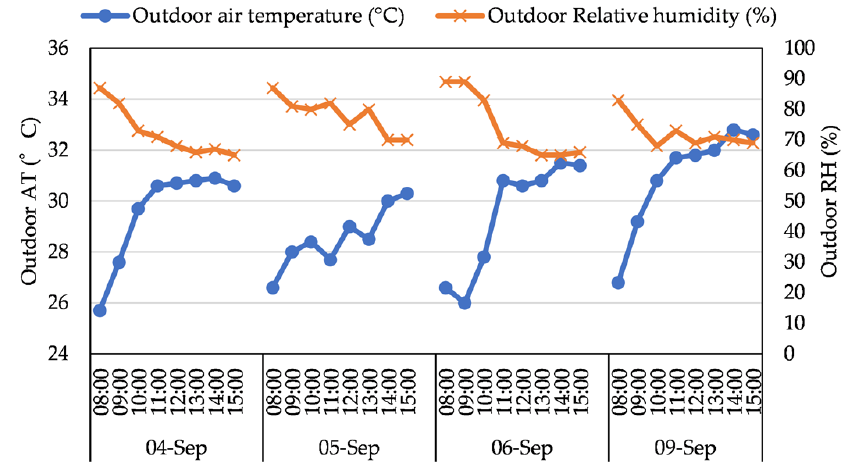
Figure 7. Outdoor summer air temperature and relative humidity in measurement time.